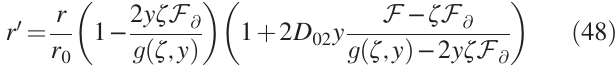
q ffiffiffi r , for various values of ζ ¼ r 0 ω 02 . ð 1 − 2 y ζ F ∂ Þð 1 þ 2 D 02 y F − ζ F ∂ Þ , where y ¼ 2 c r 0 r 0 g ð ζ ;y Þ g ð ζ ;y Þ − 2 y ζ F ∂ is plotted in (a) and shows that ð 1 − 2 y ζ F ∂ Þ is greater than 0 g ð ζ ;y Þ g ð ζ ;y Þ